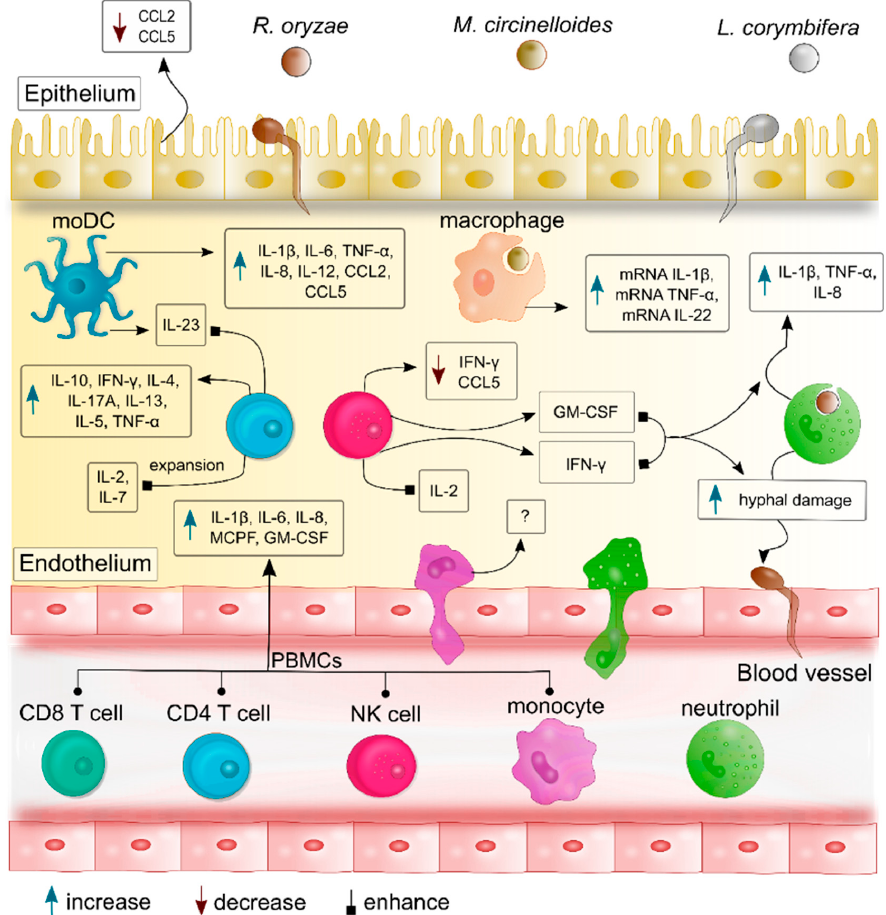
Figure 2. Cytokines and chemokines profiles produced by different host immune cells during mucoralean fungal infection. After recognition of germling and spores of the most common pathogen mucoralean fungi— R. oryzae (syn.: R. arrhizus ), M. circinelloides , and L. corymbifera —immune cells produce specific cytokines and chemokines that promote activation and expansion of other immune cells, as well as additional recruitment of leukocytes from the bloodstream to the site of infection. These cytokines regulate the inflammatory response by exerting further pro-inflammatory cascades and promoting communication among the immune cells. As an example, GM-CSF and IFN- γ produced by NK cells and T cells enhance the cytokine production of neutrophils, and their percentages of hyphal damage to R. oryzae , and L. corymbifera. Meanwhile, IL-2 and Il-7 induce the expansion of Mucorales-specific T cells and their production of IL-13, IL-5, TNF α , and IL-10. Moreover, DCs produce IL-23 which promotes the release of IL-17A by T cells.